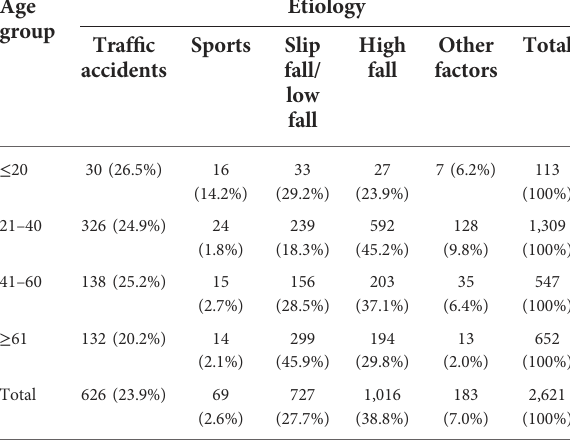
TABLE 2 Etiological composition ratio of TSCI in different age groups.